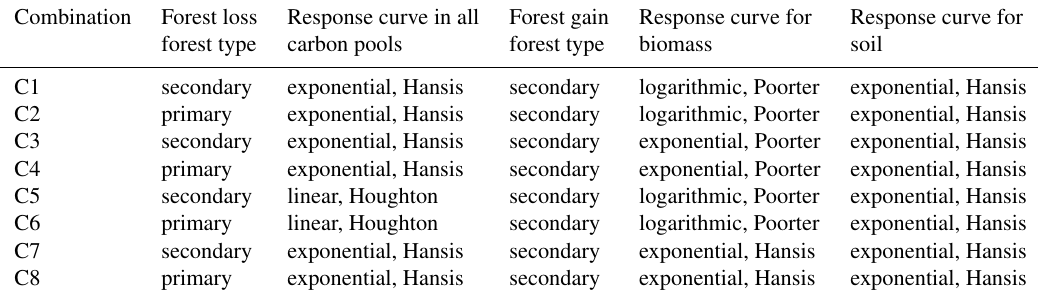
Table 2. Different combinations of response curves to calculate E LULCC . Combination Forest loss Response curve in all Forest gain Response curve for Response curve for forest type carbon pools forest type biomass soil C1 secondary exponential, Hansis secondary logarithmic,